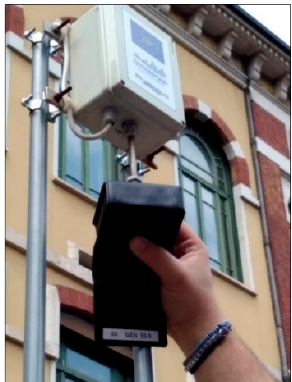
Figure 10. Operation of calibration on DYNAMAP sensor. Table 4. Calibration deviations of DYNAMAP sensors (values are in dB; N.C.: Not Calibrated).